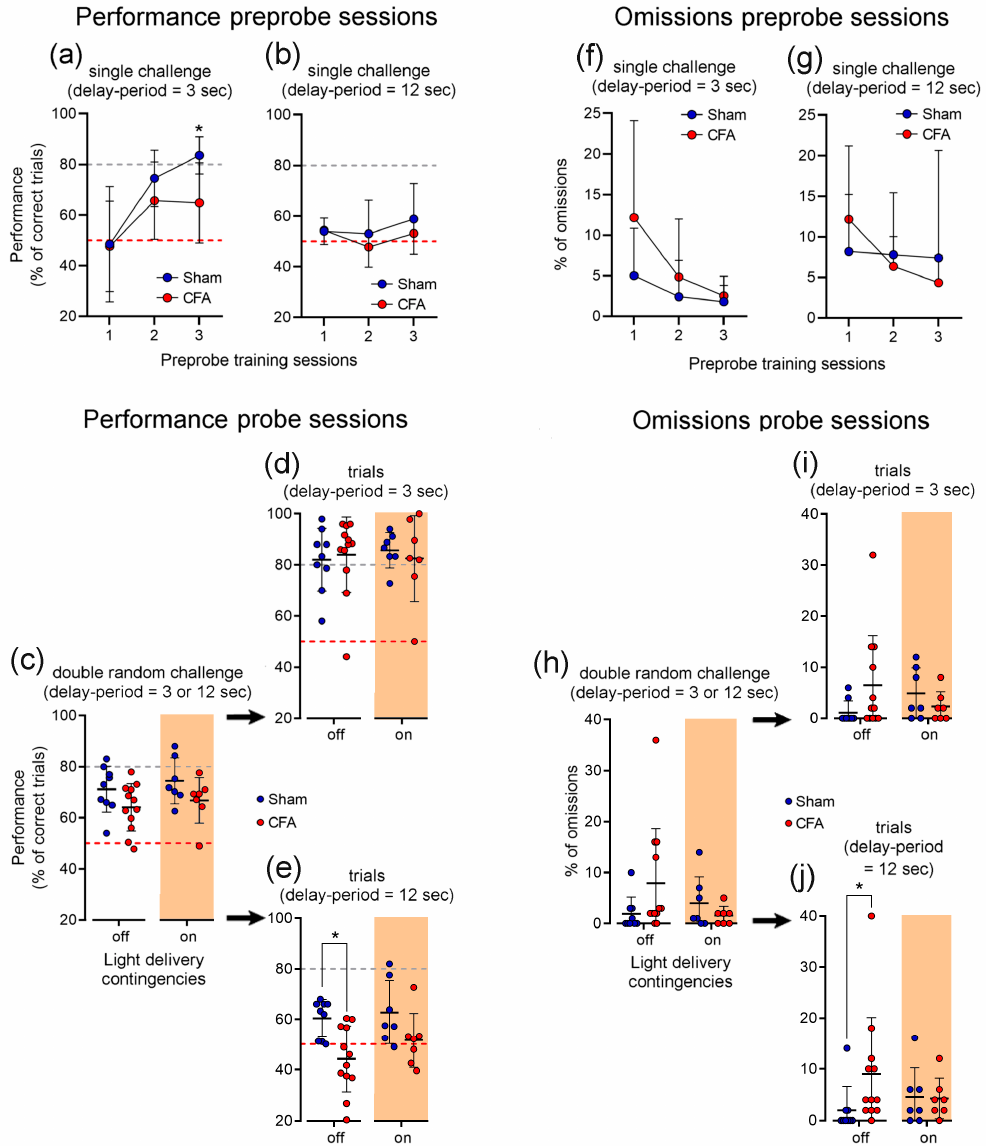
Figure 4. Effects of optogenetic photoinhibition of LHb neuron axon terminals into the VTA on working memory performance. Behavioral performance of DNMS task pre-probe training sessions using a single delay-period challenge per session: ( a ) 3, and ( b ) 12 s. ( c ) Behavioral performance of DNMS task probe sessions with optical neuromodulation of LHb glutamatergic neuron terminals into the VTA using a double random challenge per session. Averaged performance in trials with 3 s ( d ), and 12 s ( e ) of delay-period. Percentage of omissions performed in pre-probe training sessions using a single delay-period challenge per session: ( f ) 3, and ( g ) 12 s. ( h ) Percentage of omissions performed in probe sessions with optical neuromodulation of LHb glutamatergic neuron terminals into the VTA using a double random challenge per session. Averaged percentage of omissions across the trials with 3 s ( i ), and 12 s ( j ) of delay-period. Physical parameters of photoinhibition: continuous orange solid pulse at 620 nm, and intensity of 5–6 mW. Comparisons between experimental groups and light delivery protocols are based on non-parametric Kruskal-Wallis (KW) test followed by post hoc Dunn’s test. Values are presented as mean ± S. D. Significant results are indicated by * when p < 0.05.